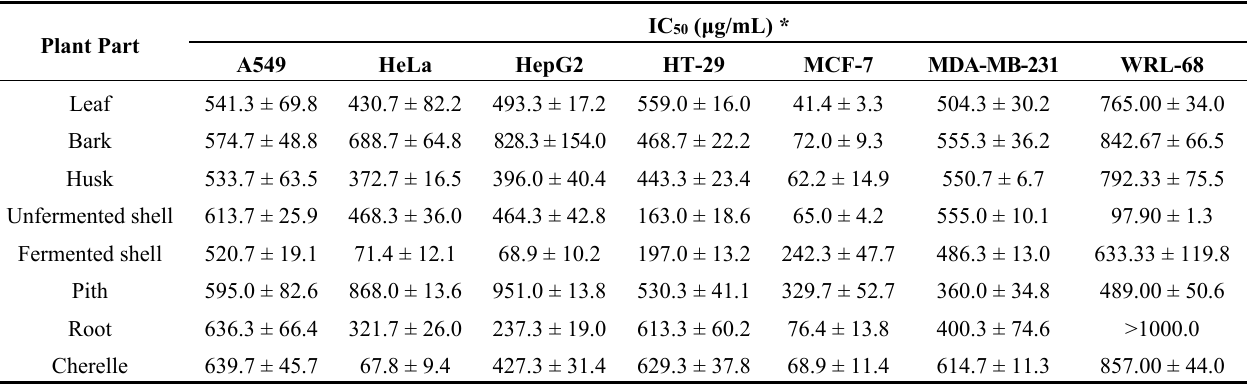
Table 4. Antiproliferative activity of cocoa plant part